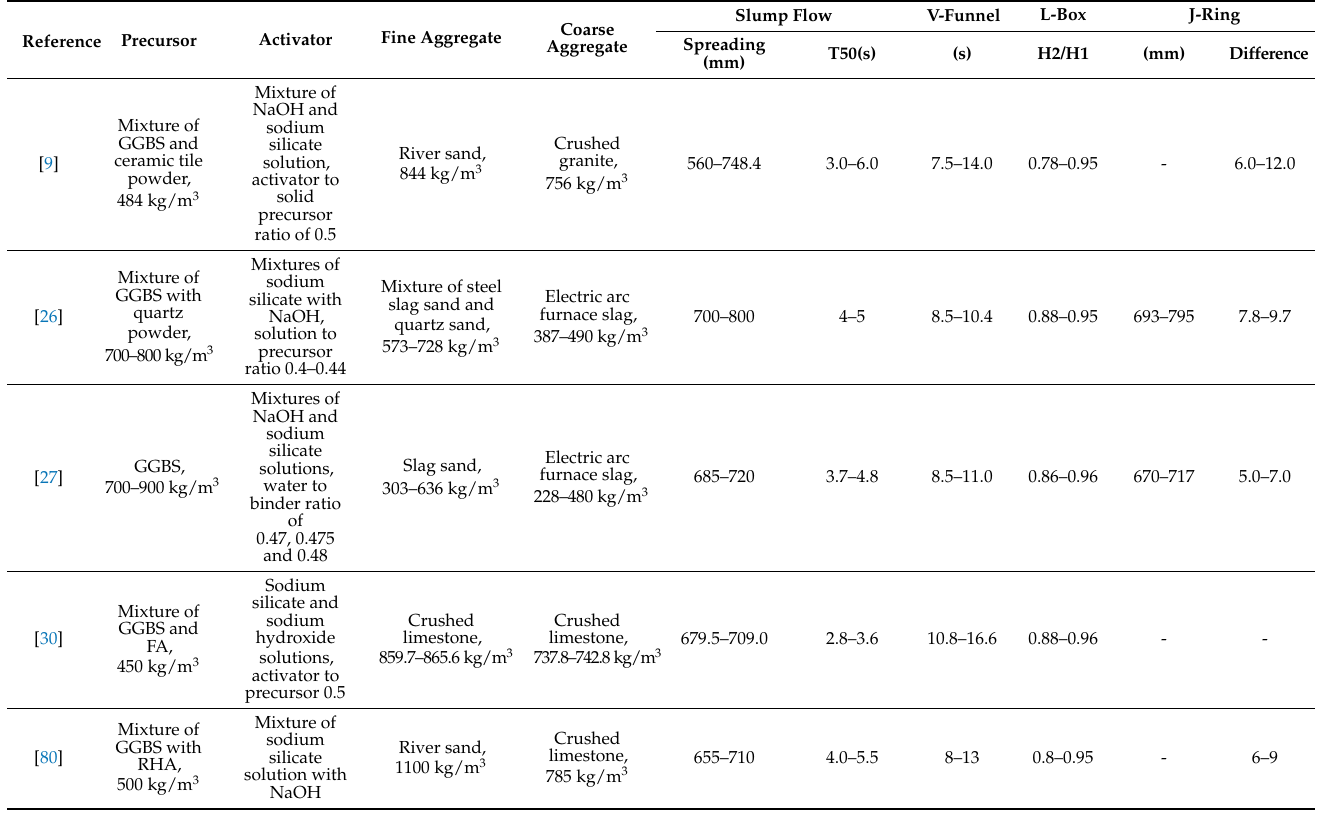
Table 1. Typical SCAAM mixture proportions and